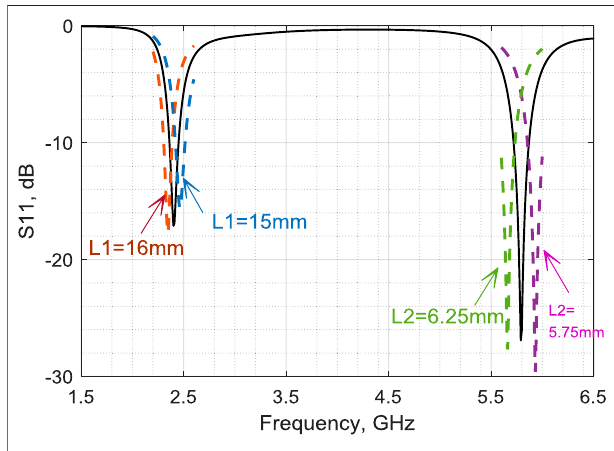
FIGURE 2 | Re fl ection coef fi cient of the dual-band IFA.